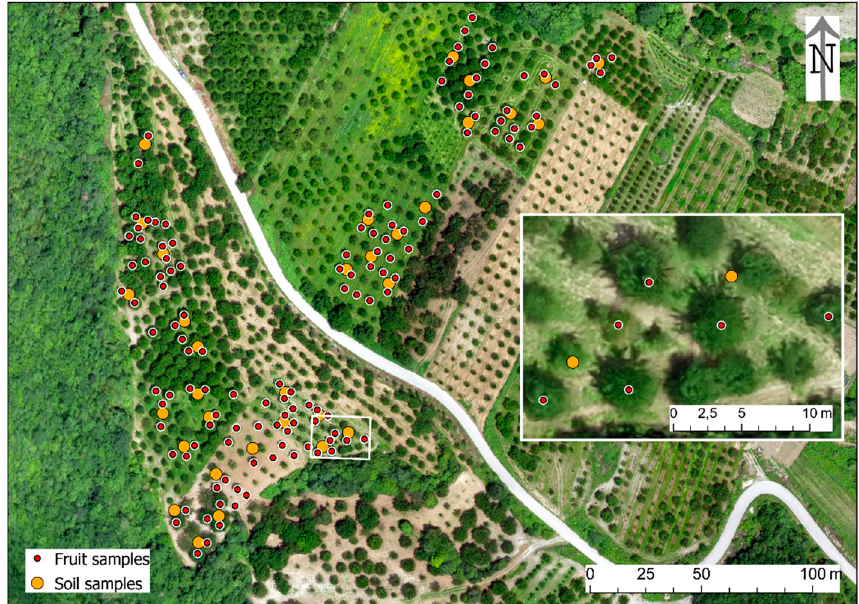
Figure 3. The fruit and soil samples in Karydia (a close view in the inset).